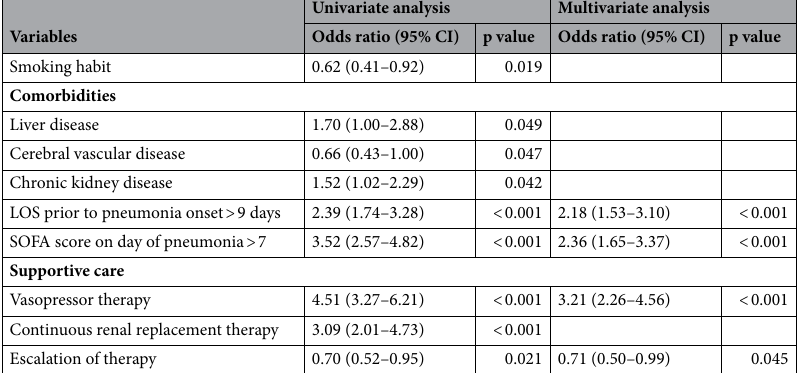
Table 2. Multivariate analysis of prognostic factors for in-hospital mortality. CI confidence interval, LOS length of stay, SOFA Sequential Organ Failure Assessment.